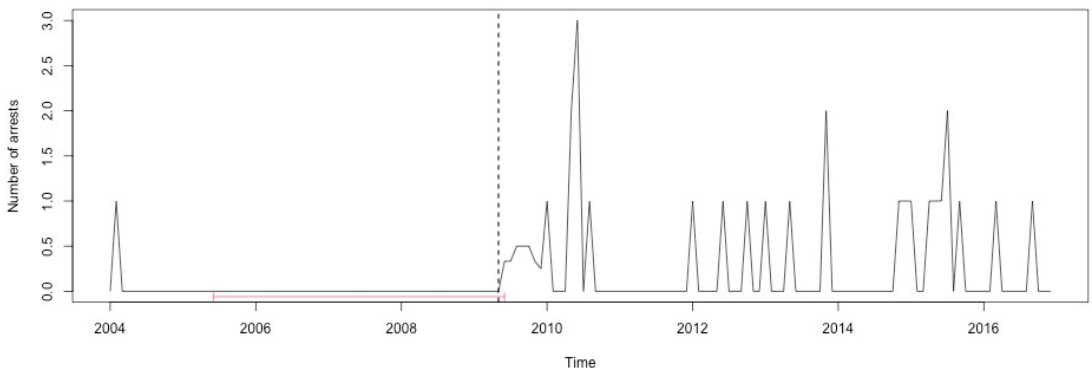
Figure A35. Precursor neighboring countries arrests 2004–2016 in the Czech Republic and structural breaks.